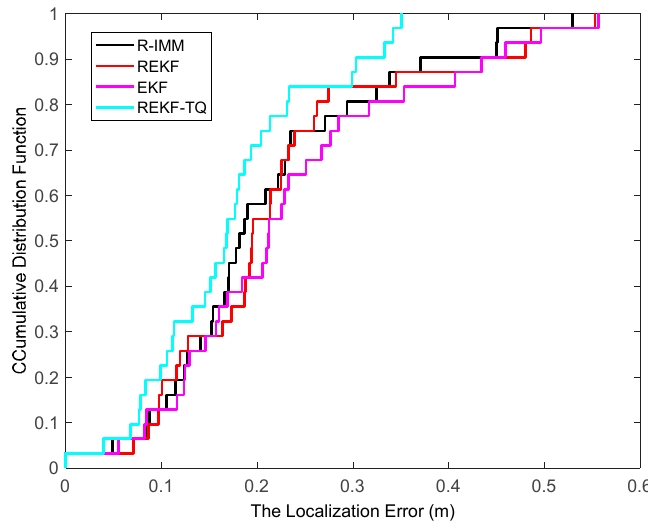
Figure 19. The localization error CDF.